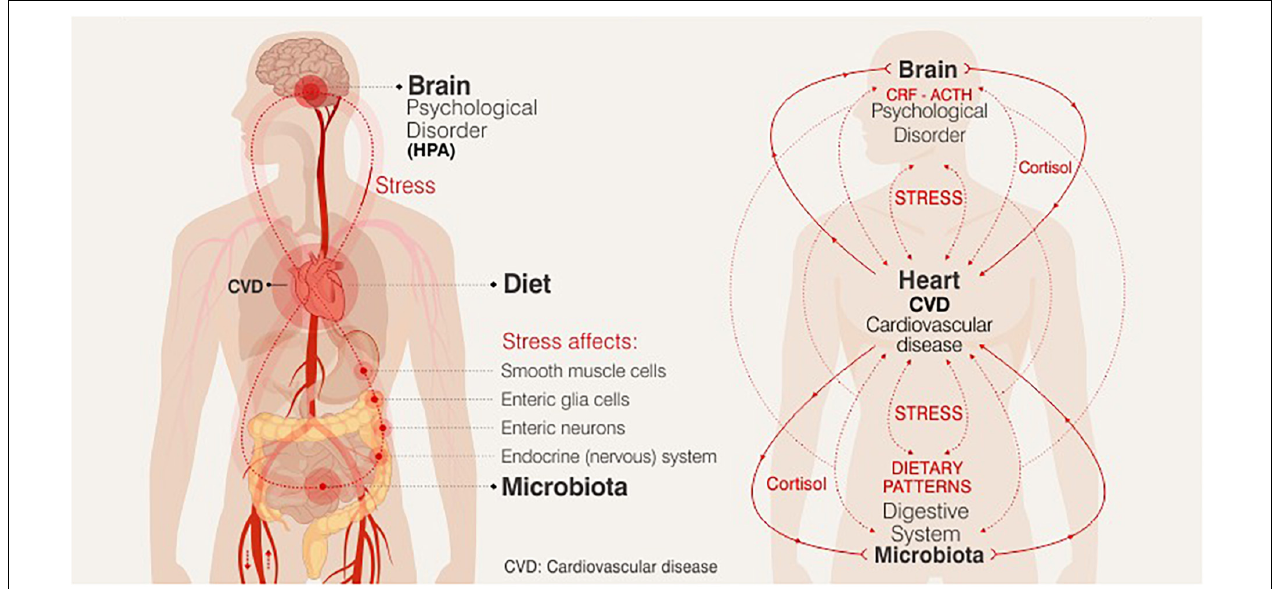
FIGURE 1 | Relationship between nutritional changes and emotional state and brain